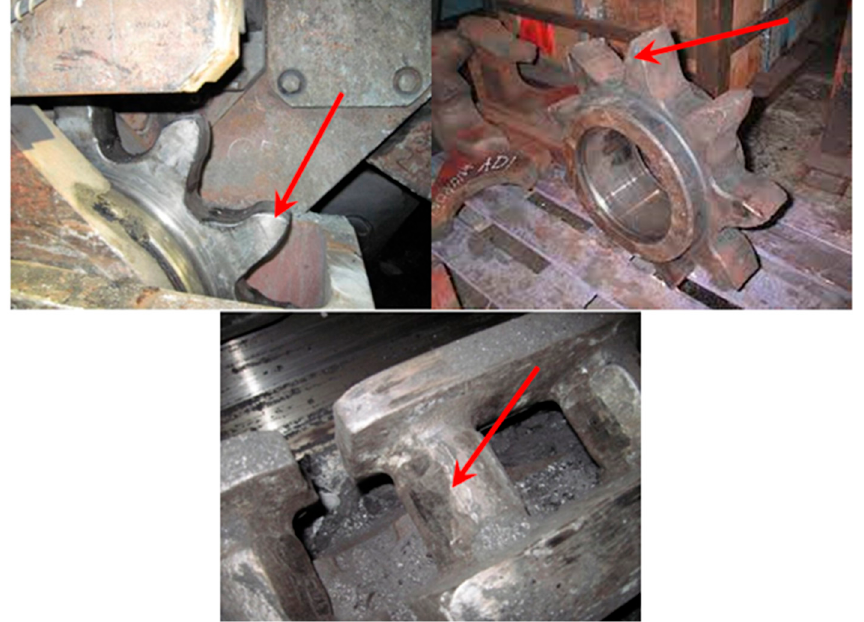
Figure 2. View of wear of gear wheels used in the Eicotrack haulage system of one of the extreme rack pins, (marked with red arrows).